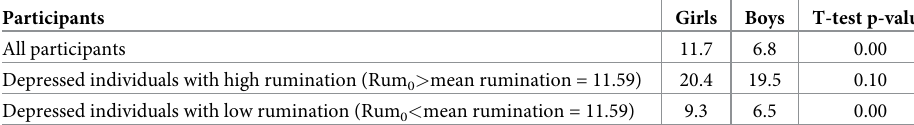
Table 3. Memory time by gender and level of